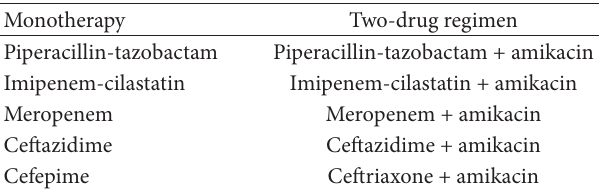
Table 3: Intravenous antibiotics for empirical therapy of fever in neutropenic